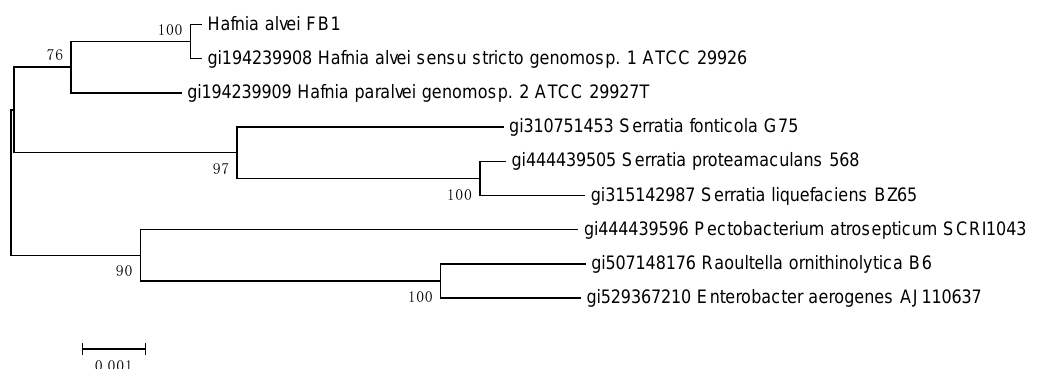
Figure 2. The 16S rDNA phylogenetic analysis of isolate FB1. The optimal tree with the sum of branch length = 0.03685960 is shown. The percentages of bootstrap test (1,000 replicates) are shown next to the branches. The tree is drawn to scale, with branch lengths in the same units as those of the evolutionary distances used to infer the phylogenetic tree. The analysis involved 9 nucleotide sequences. Codon positions included were 1st + 2nd + 3rd + Non-coding. All positions containing gaps and missing data were eliminated. There were a total of 1,485 positions in the final